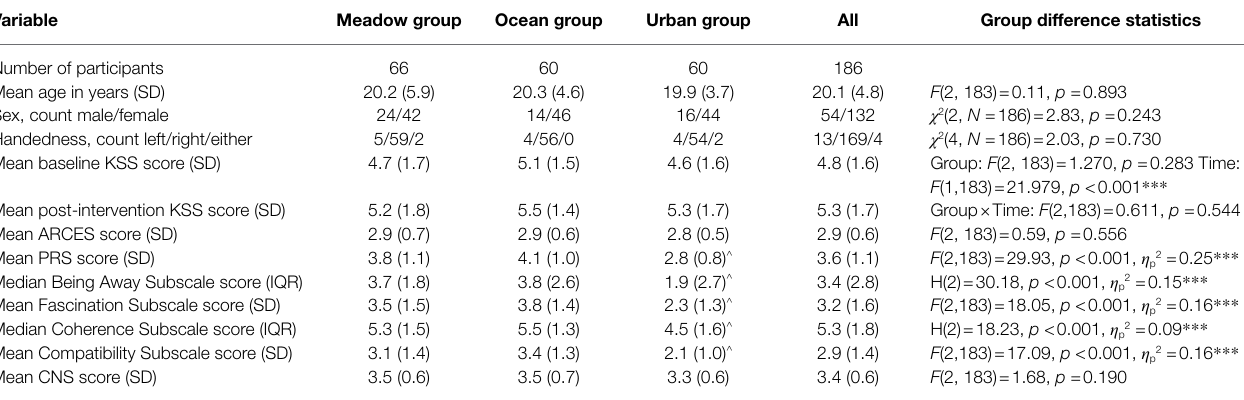
TABLE 4 | Descriptive statistics for participants’ demographics, KSS scores, ARCES scores, PRS scores, and CNS scores for each group, for Study 2.